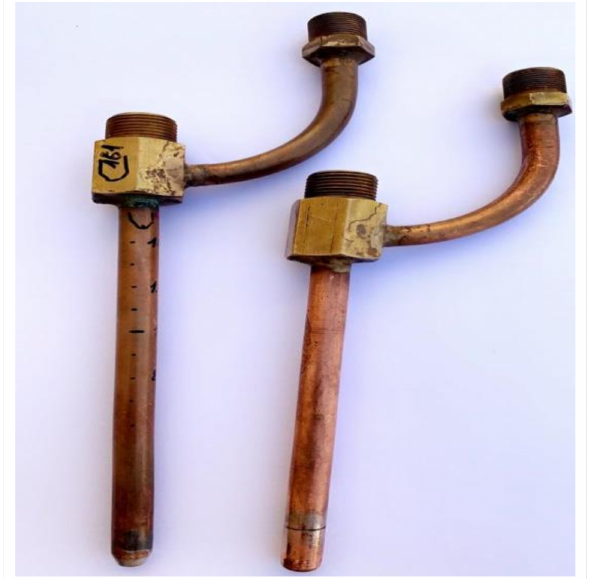
Figure 8. Two copper cathodes with different emitting materials. Two swirling rings with trenches of different depth to width ratios were used as modifications of the gas stream flowing through the plasma discharge chamber. Ring